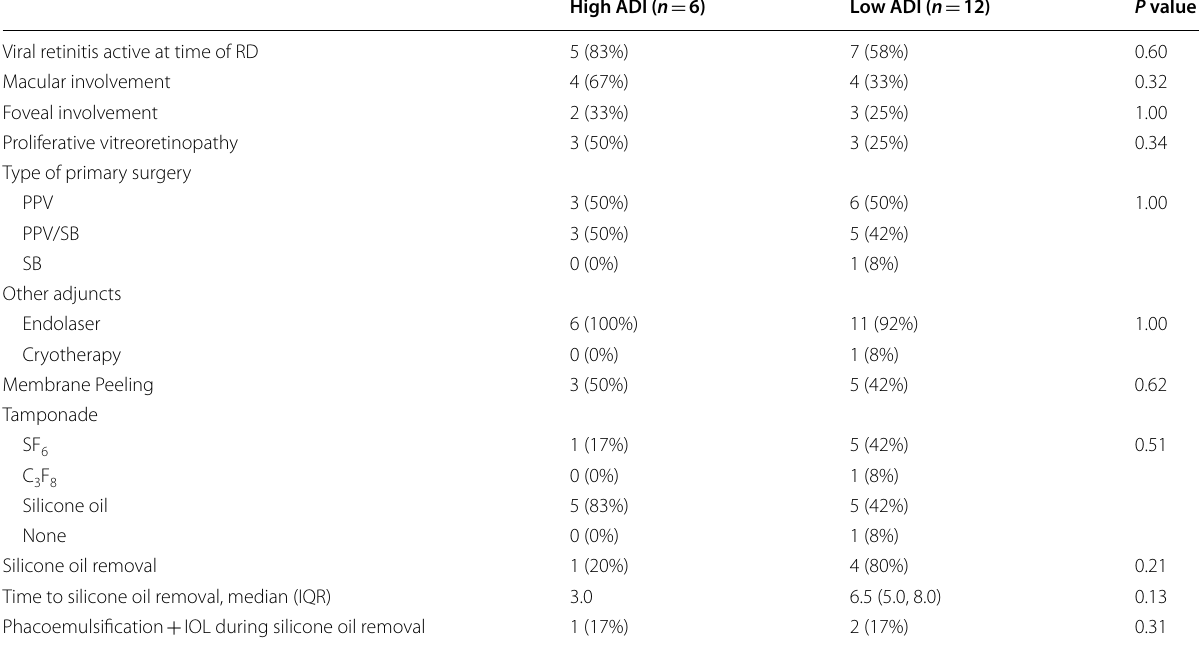
Table 3 Retinal detachment and surgical repair